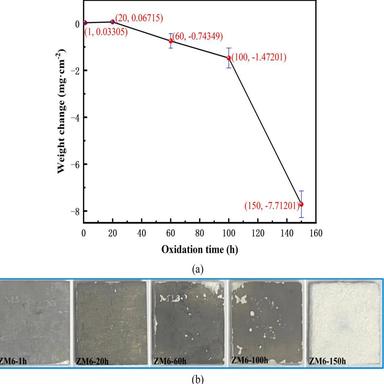
(a) Weight change curve and (b) macrographs of ZM6 alloy after the oxidation testing at 500 ℃ for 1 h, 20 h, 60 h, 100 h and 150 h.